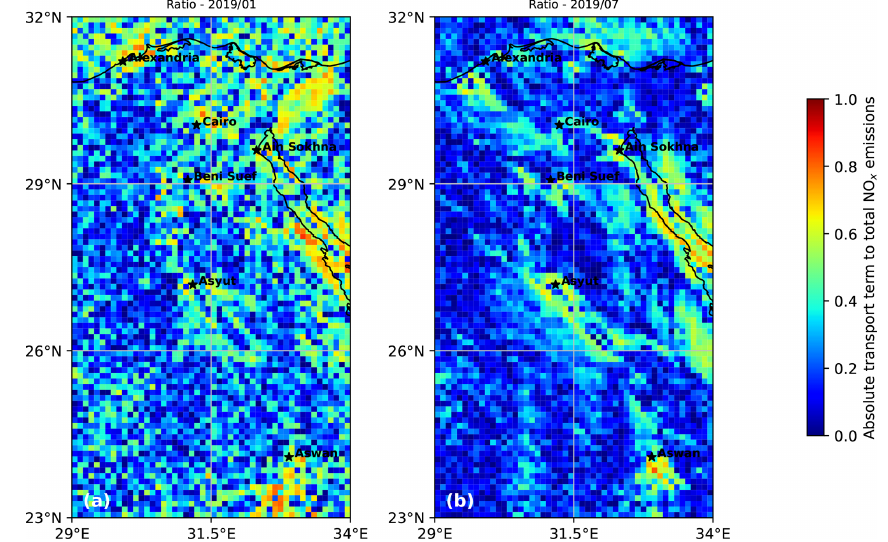
Figure 7. Share of the absolute value of the transport term in the sum of the sink term and the absolute value of the transport term above most of Egypt’s territory, indicating the local importance of the transport term in NO x emissions above mask cells. The average of this ratio is shown for January 2019 (a) and July 2019 (b)